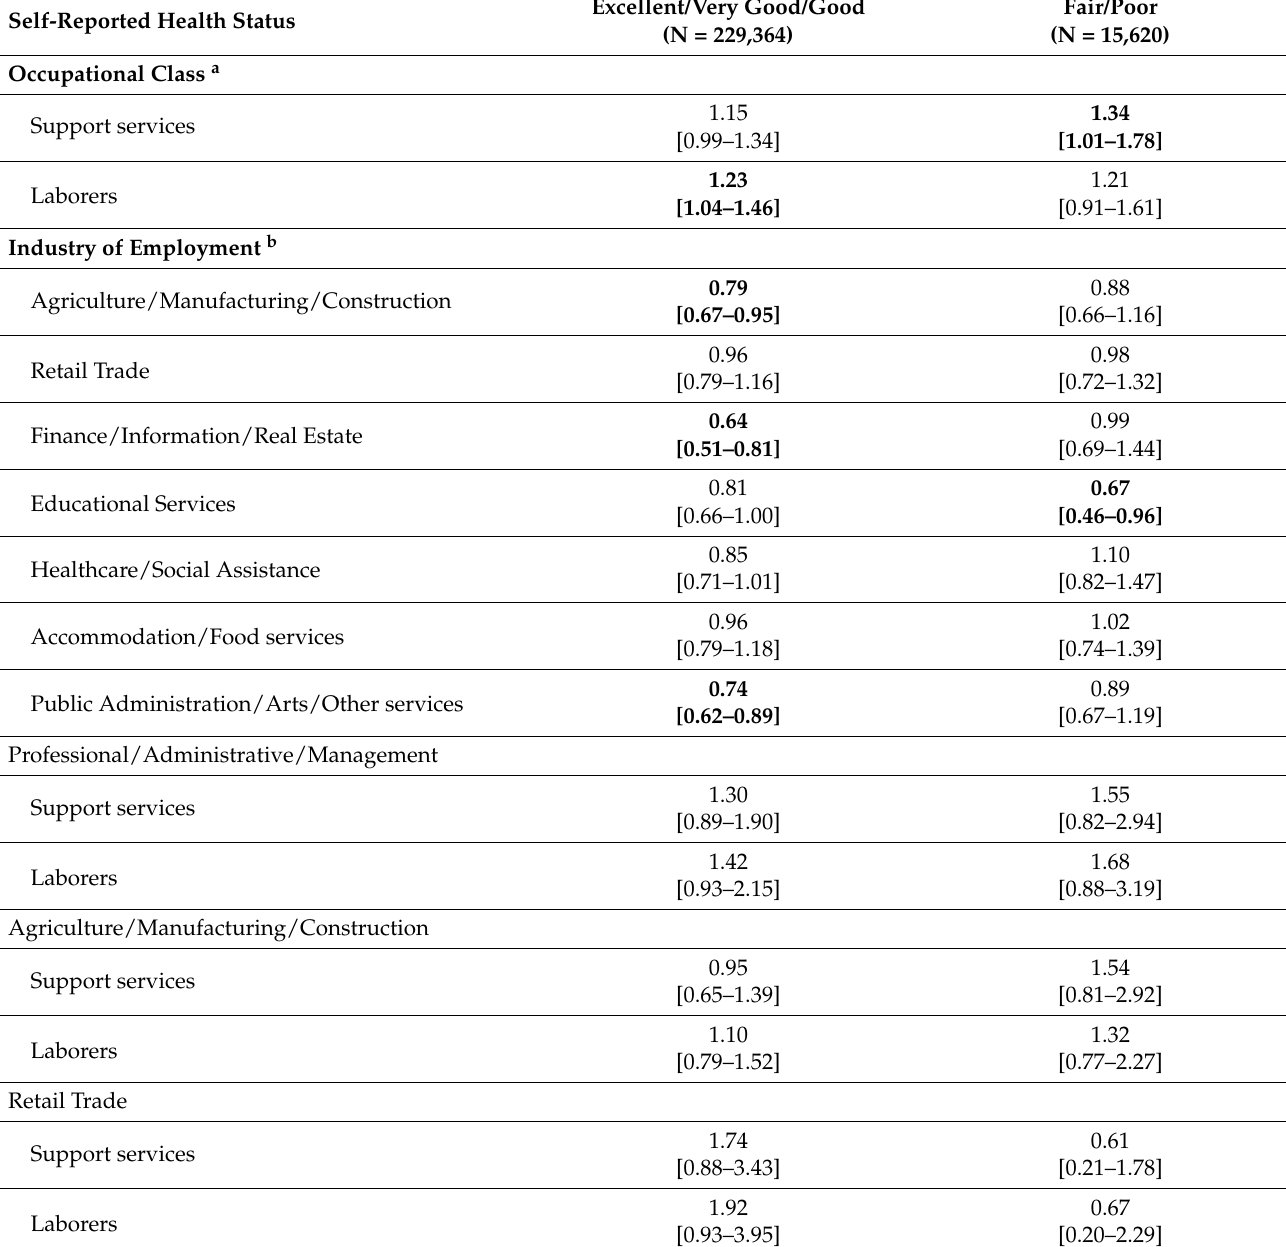
Table 6. Adjusted Prevalence Ratios (95% Confidence Intervals) for the Association Between Oc- cupational Class (compared to Professional/Management positions) and Industry of Employment (compared to the Professional/Administrative/Management Industry) and Serious Psychological Distress, Stratified by Self-Reported Health Status, National Health Interview Survey, 2004–2018, (N =